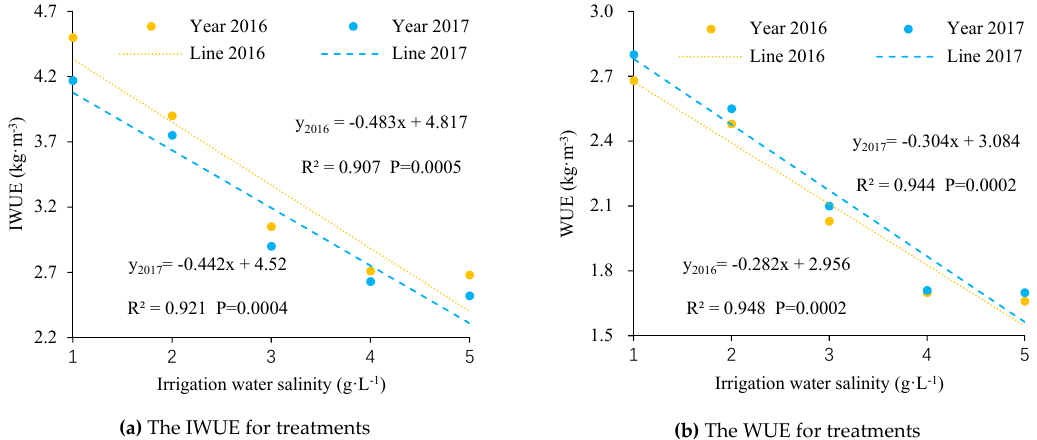
Figure 6. The irrigation water use efficiency (IWUE) and water use efficiency (WUE) for different levels of irrigation water salinity.